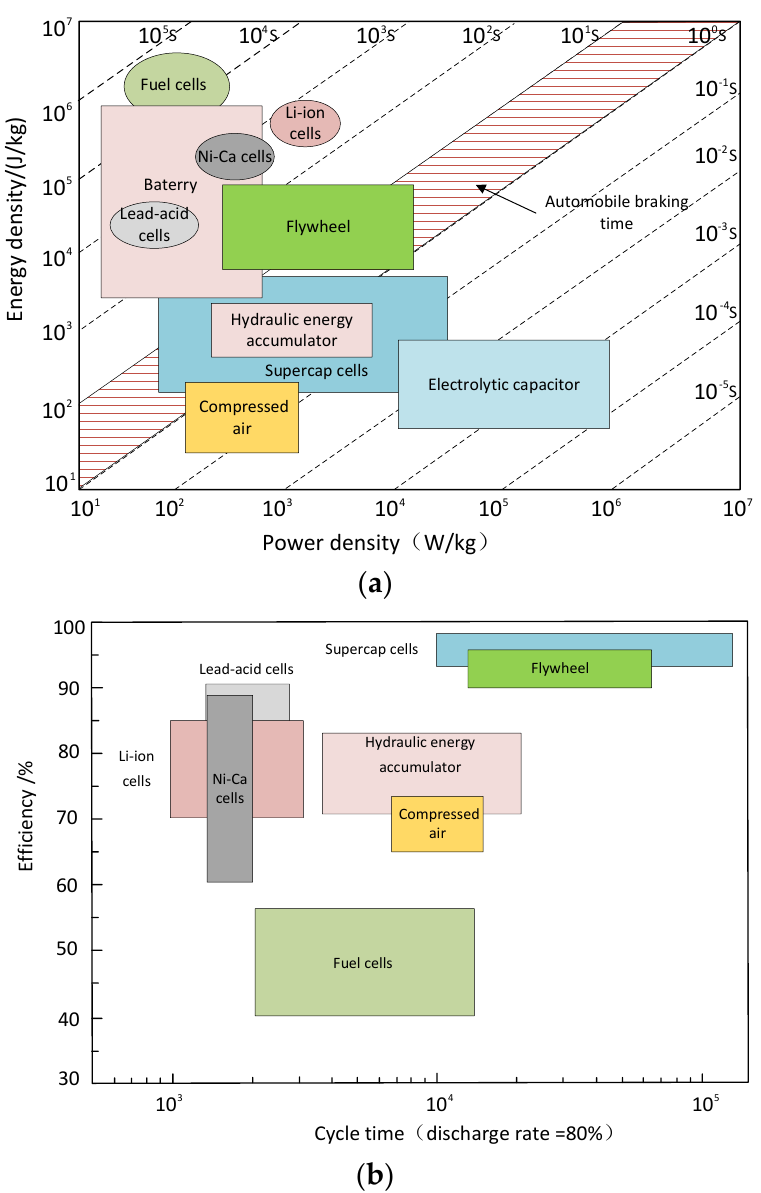
features energy flow in both directions. However, the energy conversion in the fuel cell is not reversible due to thermodynamical reasons. The characteristics of each energy storage technology are shown in Figure 1.